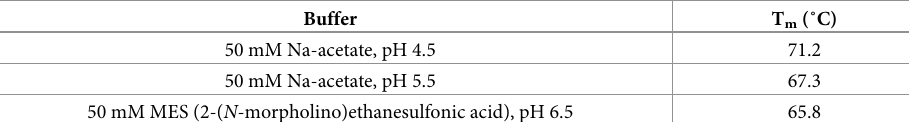
Table 5. Melting temperatures of Aa Mur by DSC in three different buffers.